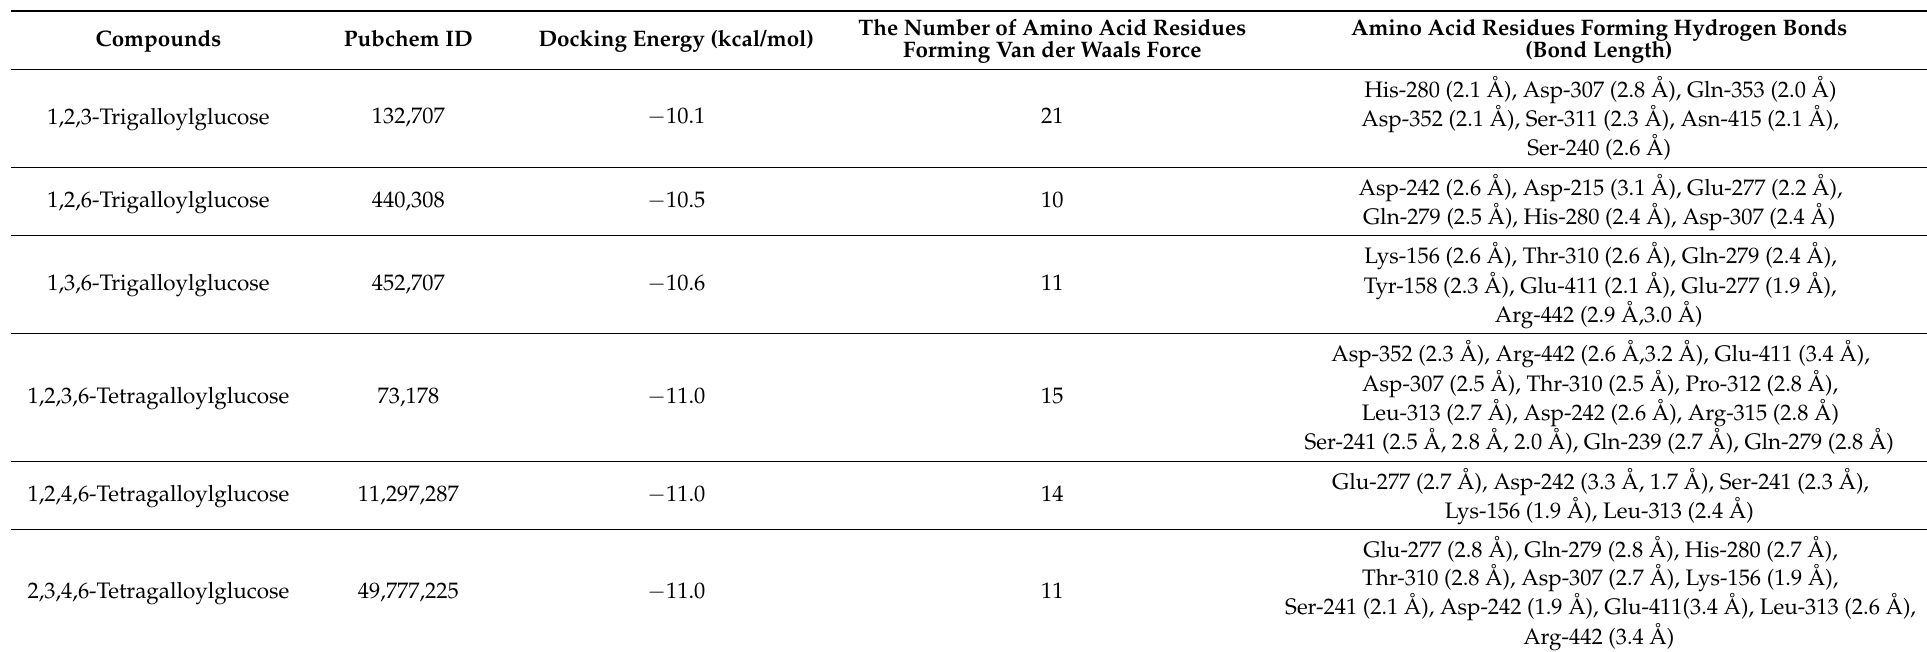
Table 3. The molecular docking results of 1,2,3-trigalloylglucose, 1,2,6-trigalloylglucose, 1,3,6-trigalloylglucose, 1,2,3,6-tetragalloylglucose, 1,2,4,6-tetragalloylglucose and 2,3,4,6-tetragalloylglucose with α